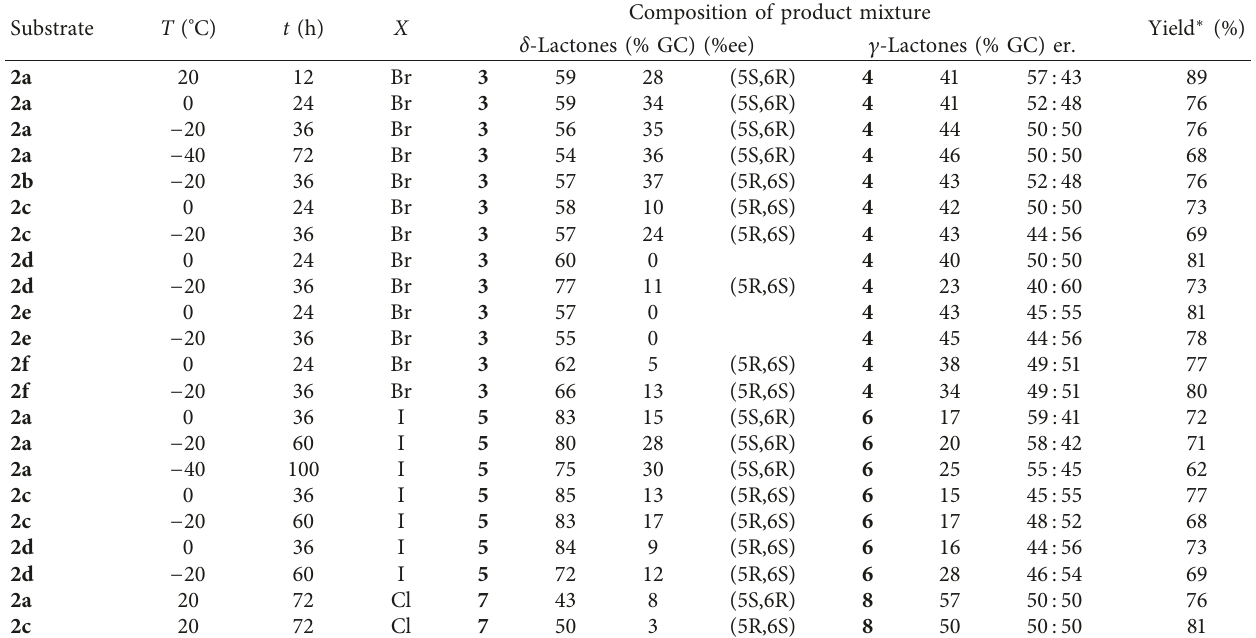
Table 1: Isolated yield ∗